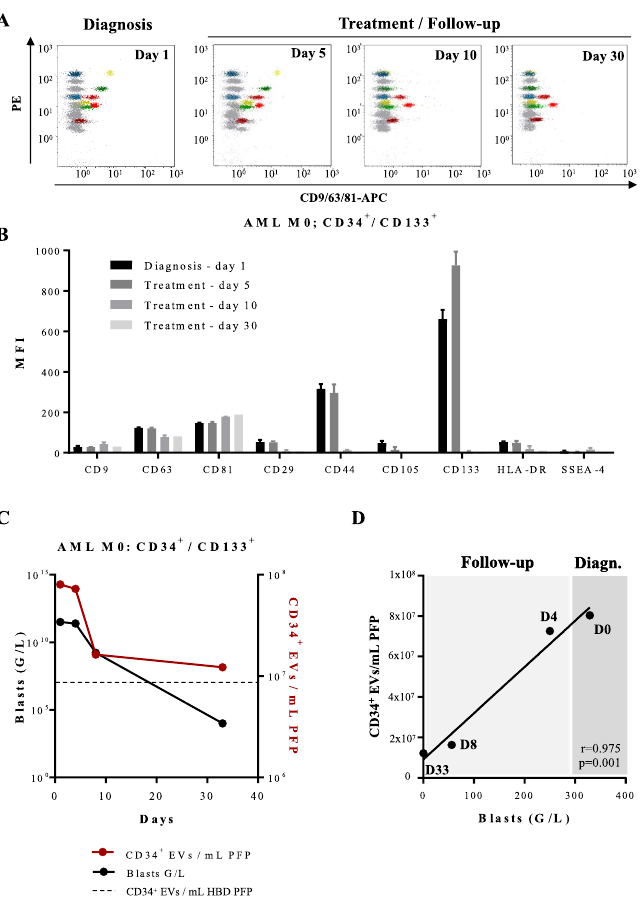
Figure 7. Multiplex bead-based flow cytometry assay — analysis of the antigenic profile of EVs ob- tained from an AML patient at diagnosis and during induction treatment: ( A ) Representative dot plots of multiplex analysis of PFP-derived EVs from an AML patient (Patient 1; Table S1) at diagno- sis (day 1), and during induction treatment on days 5, 10, and 30. ( B ) Median APC fluorescence intensities (MFI) for several bead populations revealed with the CD9/CD63/CD81 antibody mix at diagnosis (day 1), during the induction treatment on days 5, 10, and 30. EVs expressing CD44 and CD133 disappear from the phenotypic profile after day 5 of treatment. ( C ) Quantification of CD34 + EVs/mL of AML PFP measured by FT-FCM (red line) and leukemic CD34 + blasts (black line) meas- ured by standard flow cytometry. Dotted line represents quantification of CD34 + EVs/mL of HBD PFP measured by FT-FCM. ( D ) Scatter plot with linear regression line showing the correlation be- tween the concentration of CD34 + EVs/mL of PFP and the total blast count (G/L) of one AML patient (Patient 1; Table S1) at the time of diagnosis, day 0 (D0), day 4 (D4), day 8 (D8), and day 33 (D33) of follow-up. r = 0.975, p = 0.001. Standard flow cytometry performed in parallel on peripheral blood and BM samples at day 10 showed disappearance of blasts in peripheral blood (sensitivity of 10 −3 ), but not in BM (still 100% infiltration). Disappearance of BM blasts and negative minimal residual disease (MRD) were observed only at day 30, just before start of the second cycle of in- duction chemotherapy. It seems therefore not possible to use disappearance of leukemia- derived EV leukemic markers as detected by capture beads assay from peripheral blood as a surrogate marker for MRD detection.